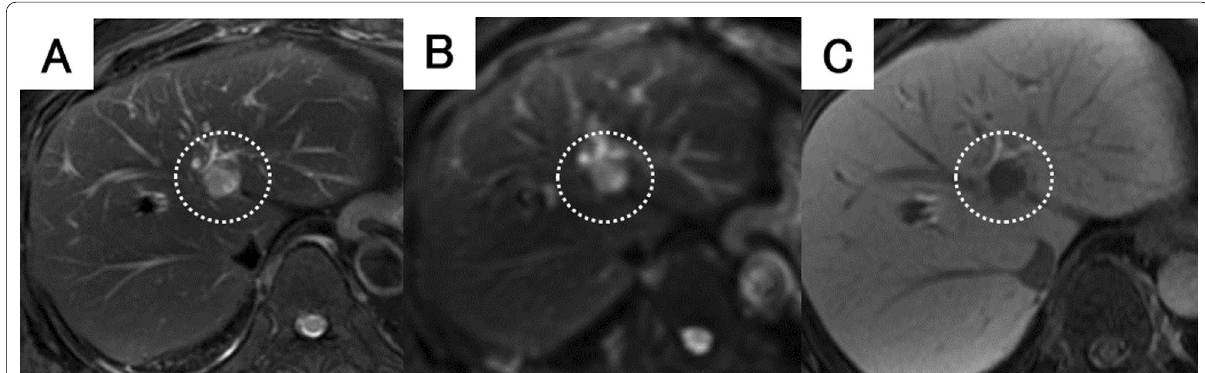
Fig. 2 Findings of ethoxybenzyl magnetic resonance imaging (MRI). A The tumor had high signal intensity upon T2-weighted imaging. B